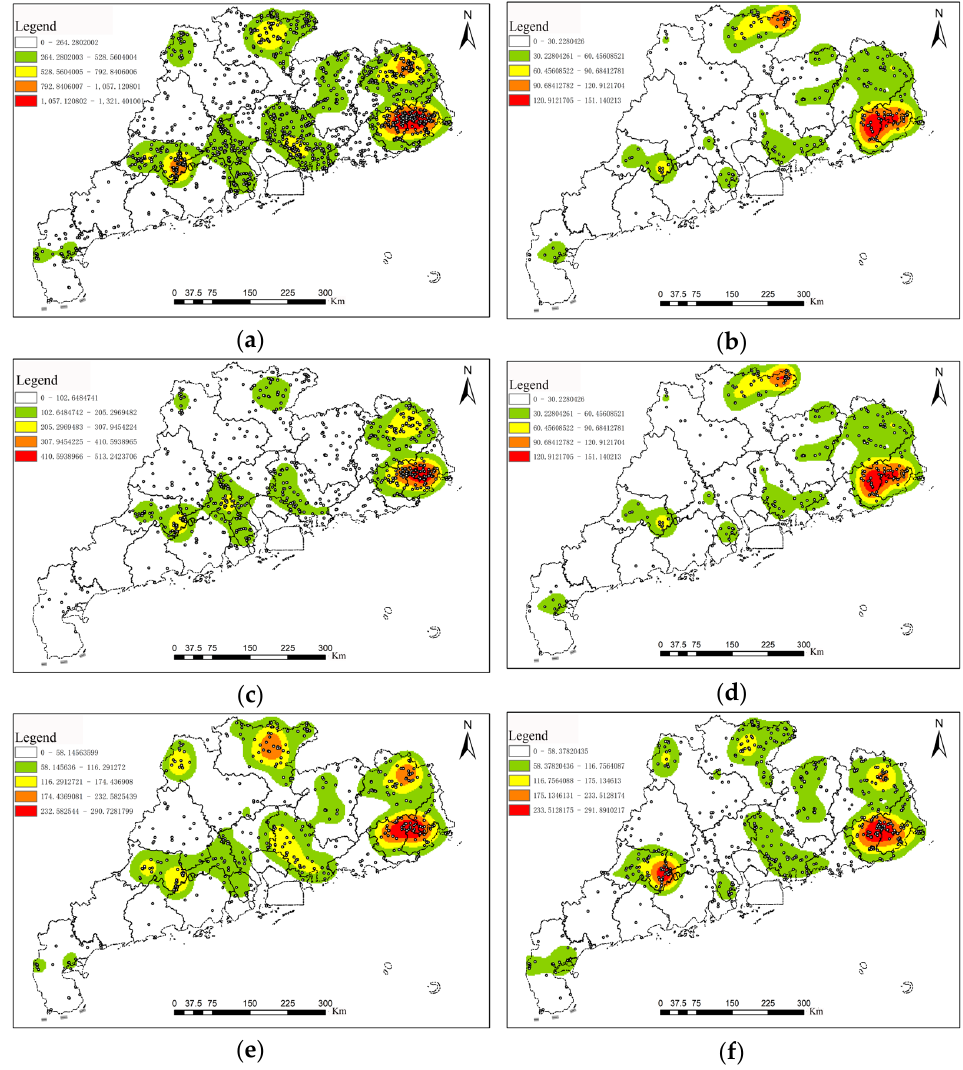
Figure 4. Spatial density distribution maps of rural tourism resources in Guangdong. ( a ) Total rural tourism resources. ( b ) Rural industry integration. ( c ) Rural settlement architecture. ( d ) Rural historic sites. ( e ) Rural folk culture. ( f ) Rural nature category.